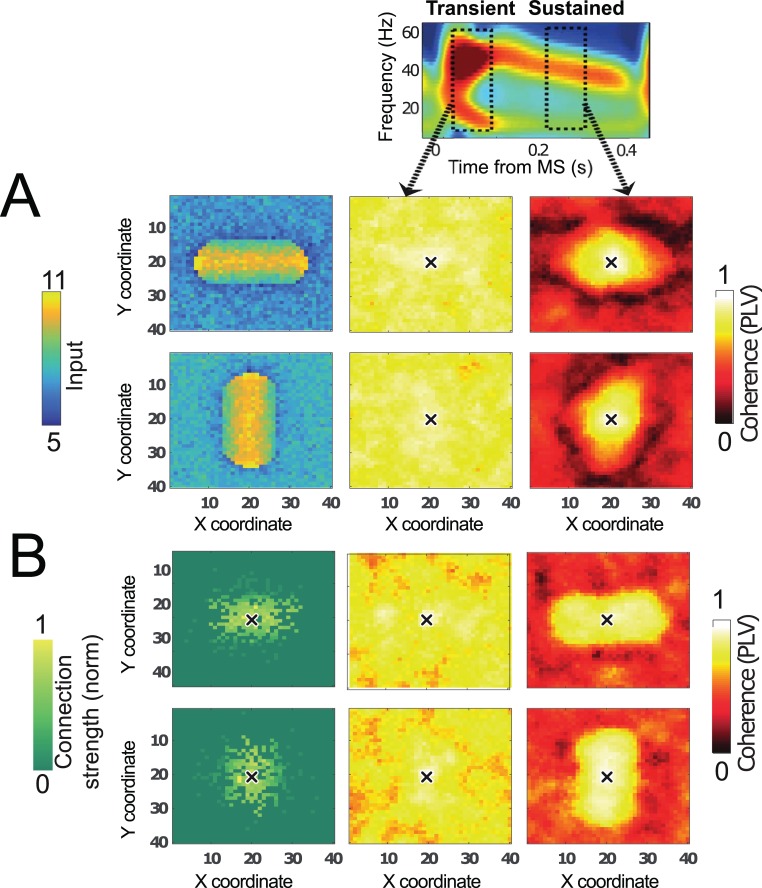
MS-dependent spatiotemporal organization of network activity.Network was a lattice with excitatory–inhibitory neurons locally connected with periodic boundary conditions (similar to Fig 2A). (A) Oriented stimulus, isotropic connectivity. Left: firing rates of excitatory RS neurons in the network that was driven by a horizontal (top) or vertical (bottom) bar-shaped stimulus. Network synchronization (PLV with the center neuron, denoted by a black cross, as reference) is shown in the transient (middle) and in the sustained (right) period with 50-ms time windows. Middle: in the transient period, PLV with the center neuron was high over the whole network due to the MS-induced reset. Right: in contrast, in the sustained period, the PLV was high only close to the reference neuron in the network center, and the PLV profile was shaped by the orientation of the bar-shaped stimulus. (B) Isotropic stimulus, anisotropic connectivity. Left: the center neuron (indicated by a black cross) was preferentially connected to neurons left and right from it (top), or to neurons below and above it (bottom). Middle: in the transient period throughout the network, the PLV with the center neuron (indicated by a black cross) was high. Right: during the sustained period, PLV was only high close to the reference neuron, and the shape of the PLV profile reflected the preferred connectivity orientation. MS, microsaccade; PLV, phase-locking value; RS, regular-spiking neuron.